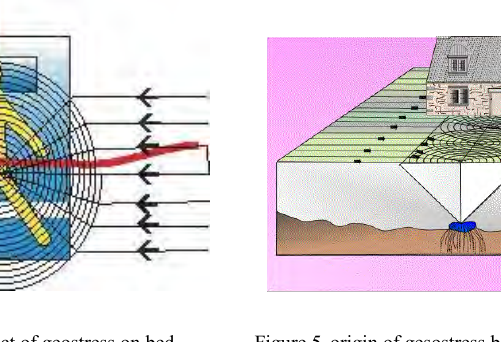
Figure 4 effect of geostress on bed Figure 5 origin of gesostress below homes Figure 6 geo-energy grids and